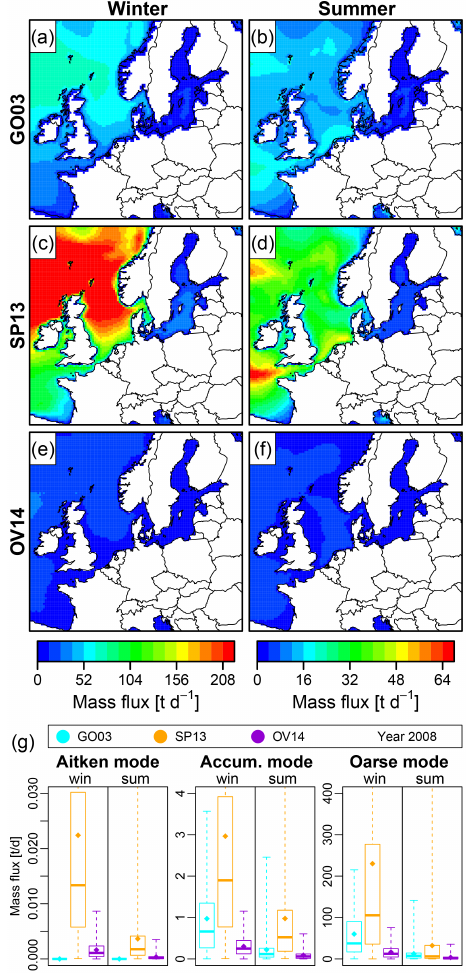
Figure 7. Sea salt mass emissions in tons of sea salt per day and grid cell [td − 1 ] (total mass of sea salt and not mass of sodium). (a – f) The 2-month average mass emissions in winter (left column) and summer (right column). The emissions were calculated using the GO03, SP13, and OV14 (top to bottom) emission parameteriza- tions. The color scale is the same for all plots in the same column. (g) Box plots of mass emissions in the Aitken, accumulation and coarse modes (left to right) at one location in the German Bight (Fig. 5) during summer and winter